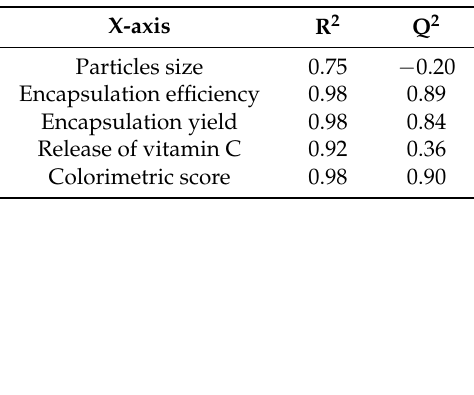
Table 5. Statistical evolution of each response